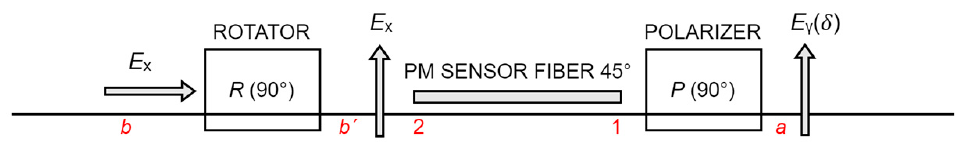
Figure 2. Arrangement of path a : a → 1 → 2 → b ’ → b .